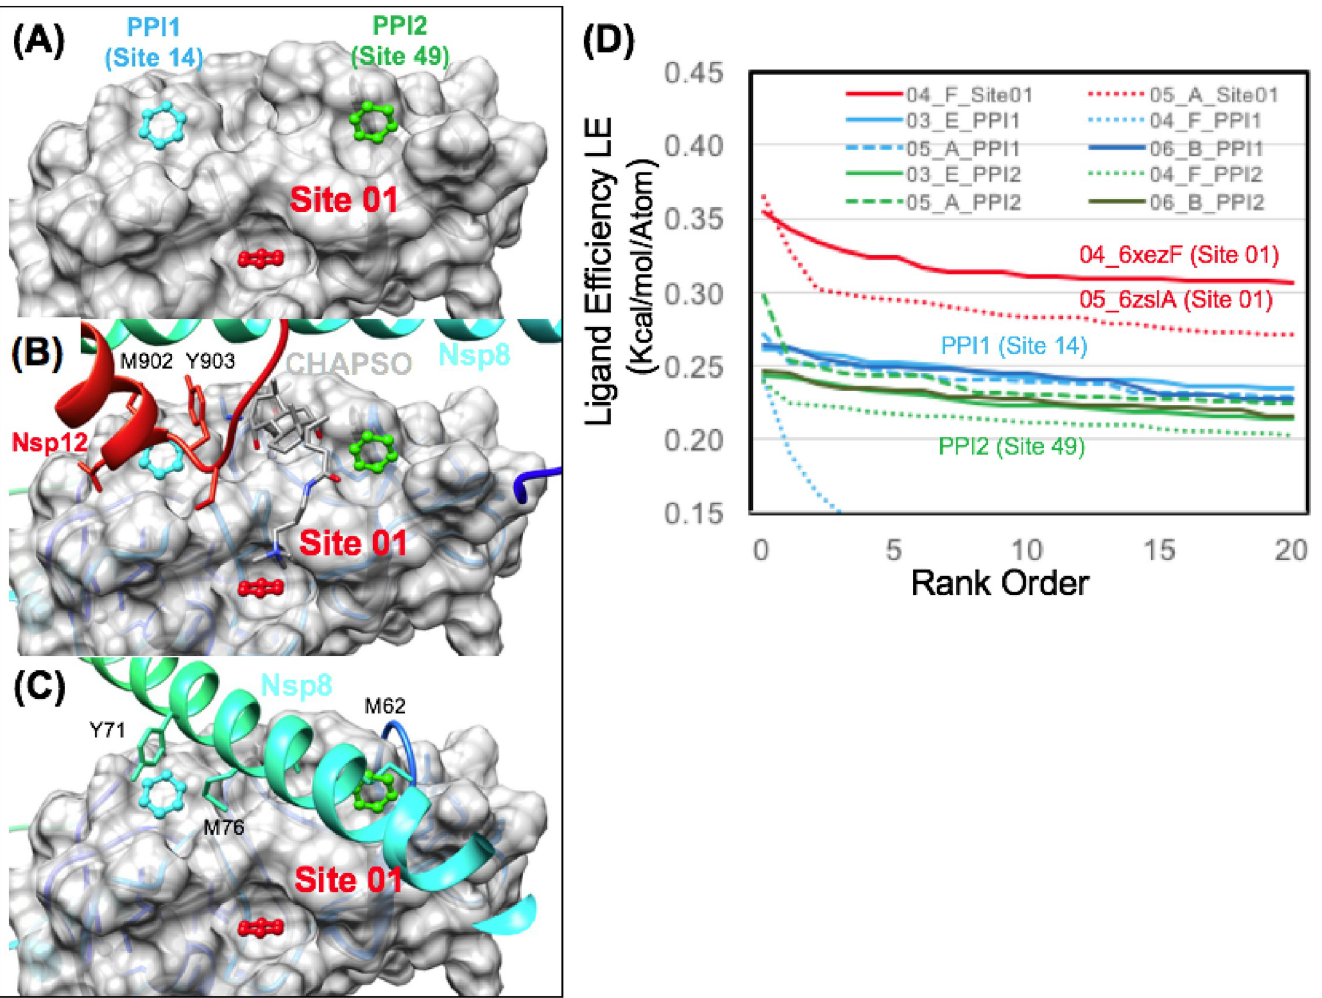
Fig 15. Nsp13 helicase ZBD allosteric Site 01 is more favorable than ZBD protein-protein interaction (PPI) sites. Pharmacophore Site 01 (red), Site 14 (cyan) and Site 49 (green) are shown on a surface diagram (A) of the ZBD. PPI1 (Site 14) overlaps with Nsp12-Nsp13 (B) and Nsp8-Nsp13 (C) PPI sites, where PPI2 (Site 49) overlaps with residue M62 of Nsp8 on the Nsp8-Nsp13 complex of the new replicase complex. Ligand efficiency from computational fragment screening (FRAG100) shown in (D) demonstrates that Site 01 (red) is more favorable than both of the PPI sites (cyan) and (green). Site 01 (red) was found to be most favorable for ligand binding in two new independently determined SARS-CoV-2 [04_6xezF] and [05_6zslA] Nsp13 experimental